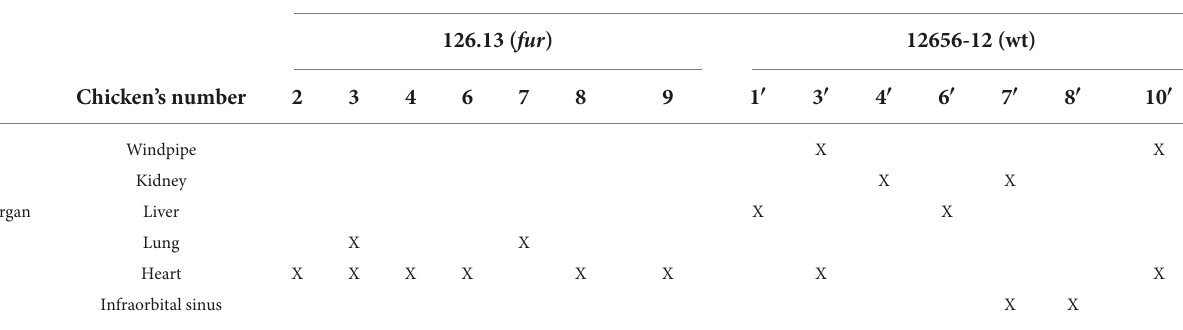
TABLE 1 Re-isolation of G. anatis 12656-12 and (cid:127) fur 126.3 strains from SPF chickens intranasally inoculated.